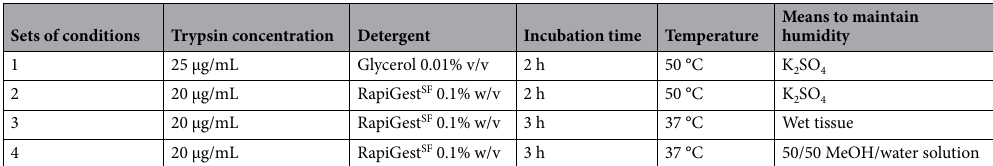
Table 1. Summary of the sets of proteolytic conditions trialled for the optimisation of the detection of protein biomarkers of breast cancer.